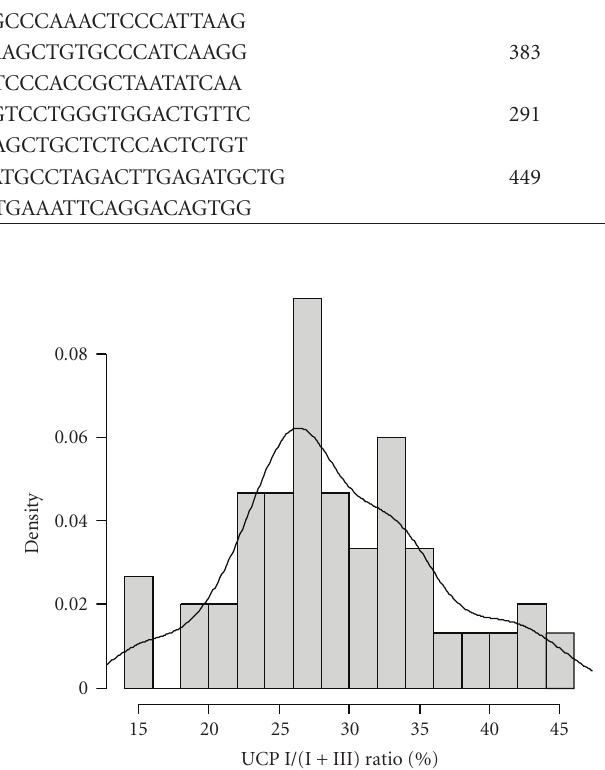
Figure 2: Distribution of UCP I/(I + III) ratio in our